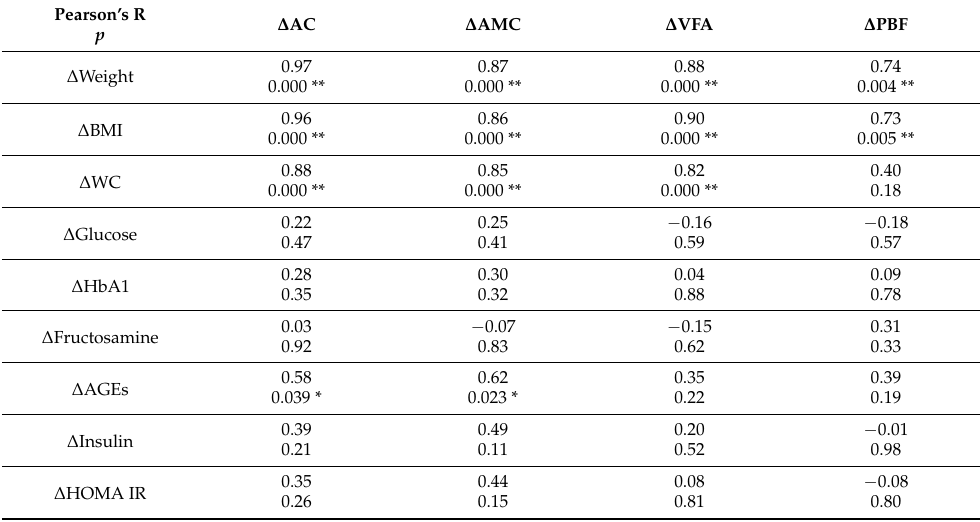
Table 5. Correlation analysis among studied parameters in obese normoglycemic women ( n = 15) before and after the weight reduction program. The correlation is significant: * p ≤ 0.05; ** p ≤ 0.01. Pearson’s R p